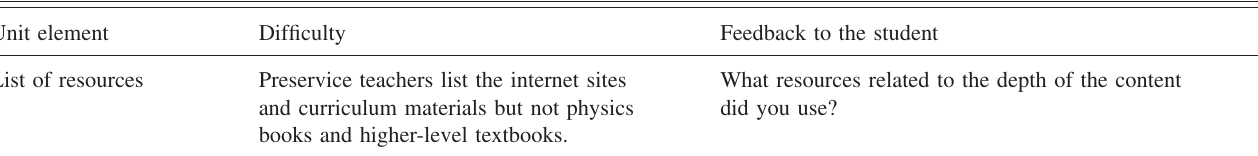
TABLE V. (cid:1) Continued. (cid:2)